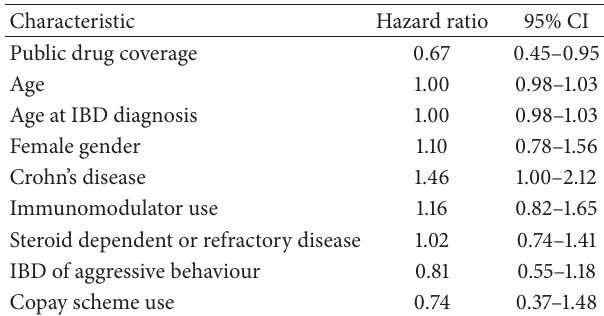
Figure 2: Rates of hospitalizations and emergency department visits stratified by public versus private drug insurance coverage. Additional sensitivity analyses are performed in which the following groups were excluded (excl): those who received first anti-TNF dose as inpatients (Inpt) or through a compassionate use program (Comp); those with private drug insurance coverage who received supplemental public funding (Copay). All rate differences between private and public drug coverage were statistically significant ( ∗ 𝑃 < 0.001 ). Table 3: Results of the Cox regression analysis of type of drug insurance coverage and time to first anti-TNF